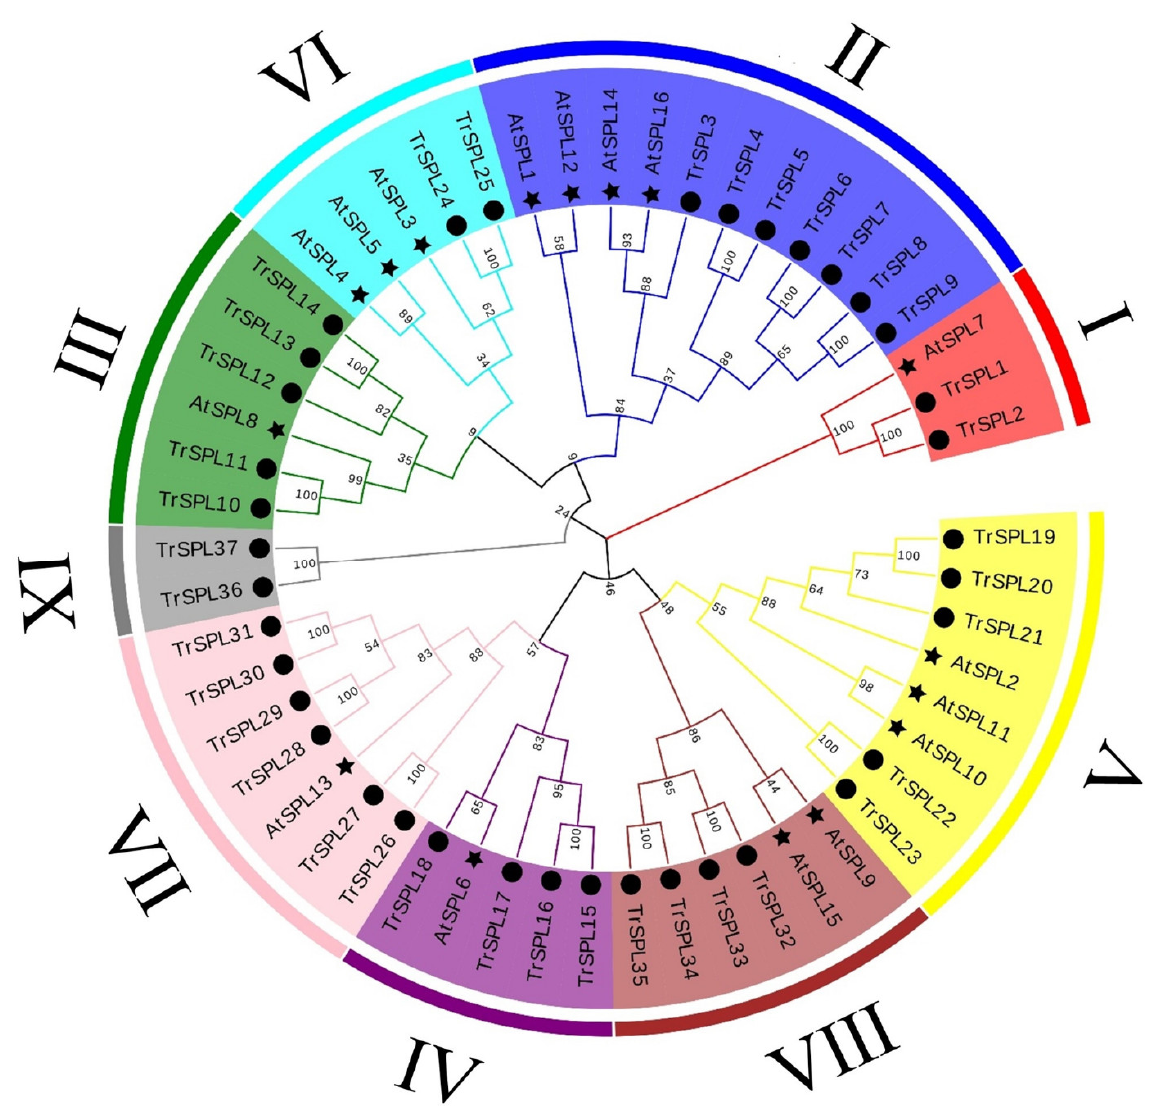
Figure 1. Phylogenetic analysis of SPL proteins in A. thaliana and T. repens . Phylogenetic trees were plotted using the neighbor-joining (NJ) method with a bootstrap value of 1000. Fifty-three genes were divided into nine clades ( Ⅰ – Ⅸ ) and identified with different colors. The black circle represents T. repens , and the black pentacle represents A. thaliana .